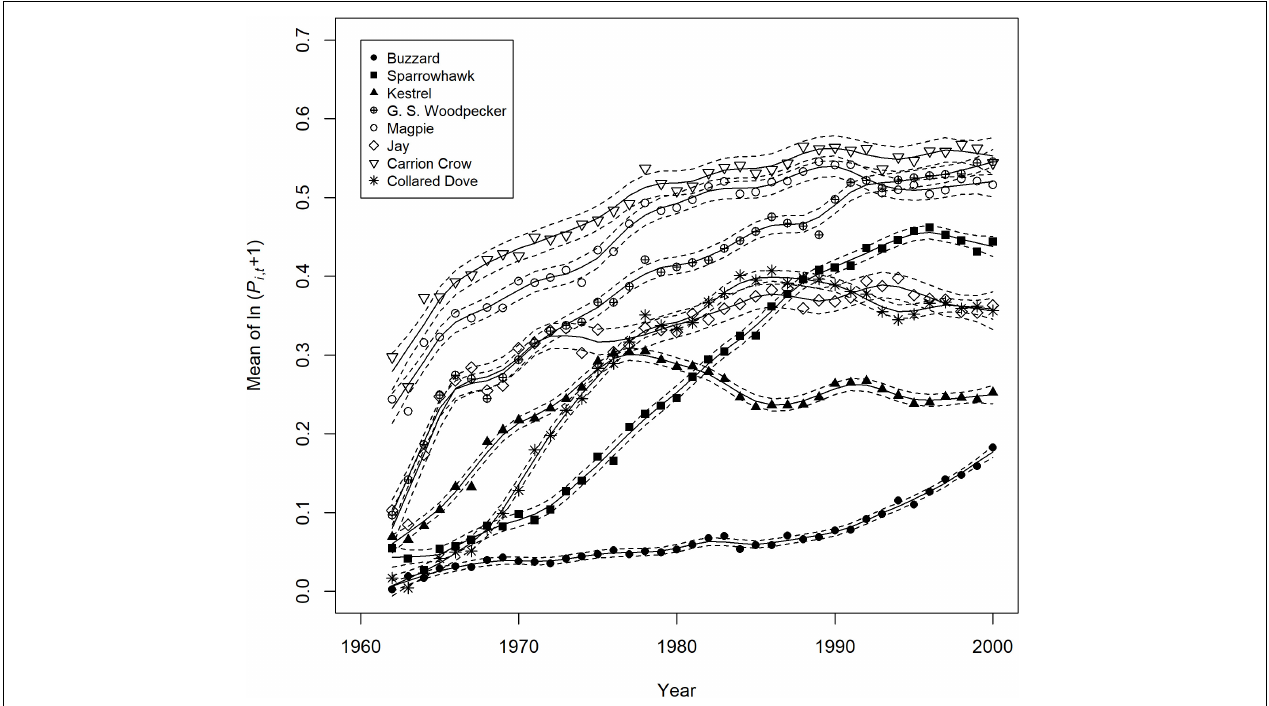
FIGURE 3 | Trends in mean predator site occupation 1962–2000. This is expressed as the mean of ln( P i , t + 1), where P is the year and site-specific estimate of predator activity derived from the binary logistic model (n.b. P i , t + 1 is the unit measurement on which predator effect estimates are based). Trend lines ± 2 standard errors were fitted with the loess smoother of the GAM package in R using a span of